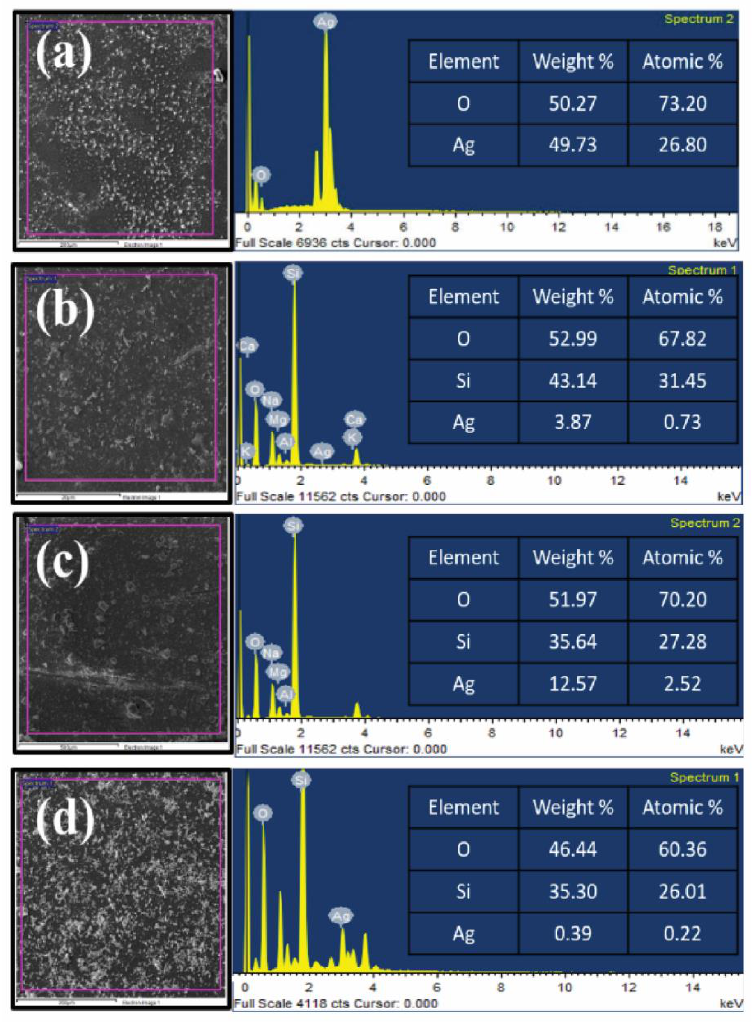
Figure 3. EDX analysis of green synthesized Ag-NPs using plant extracts of ( a ) Aloe vera , ( b ) lemongrass, ( c ) mint, ( d ) coriander.